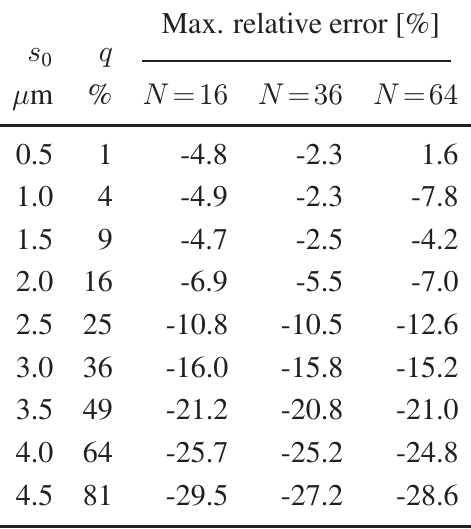
Table 5 . Maximum relative errors in the translational motion damping coef fi cient Z PPR method. Average speci fi c admittances are used for the perforation and D parameters are the same as in the simulations in Table 2.